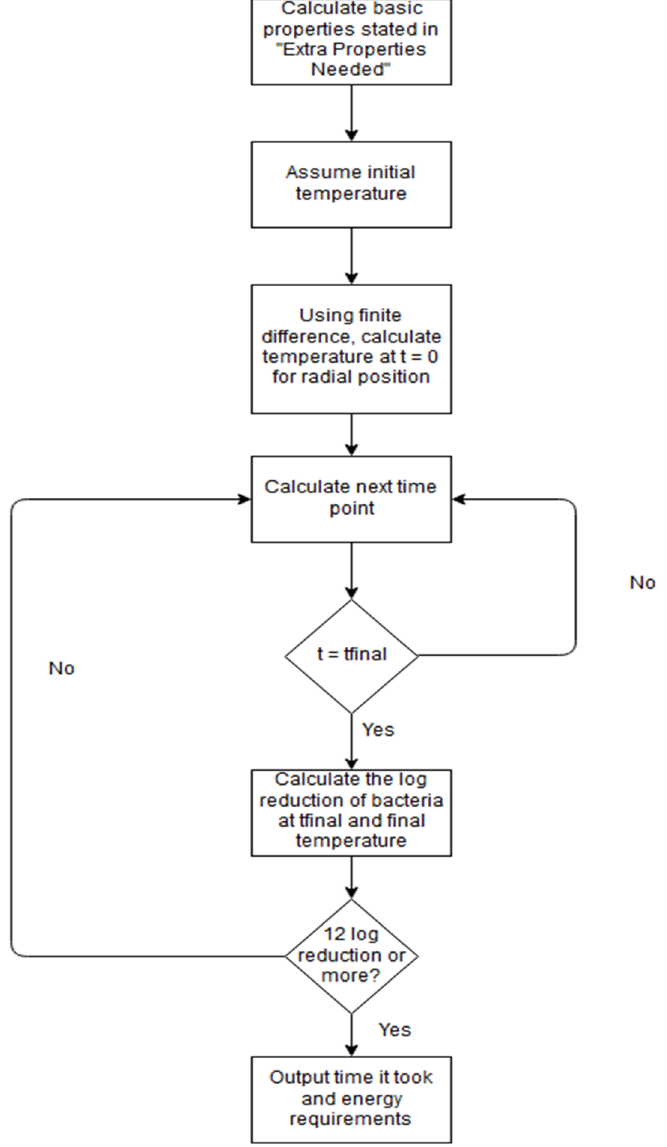
Figure 2. Example diagram demonstrating organization of larger solution method.